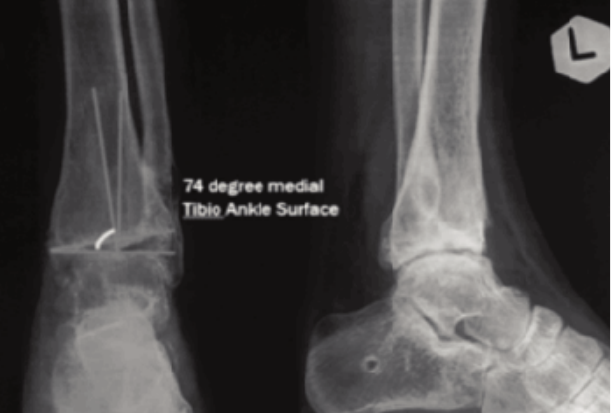
Pre-operative condition. Left ankle pre-operative imaging, showed varus deformity with TAS angle 74 o (internal documentation). Fig. 1: